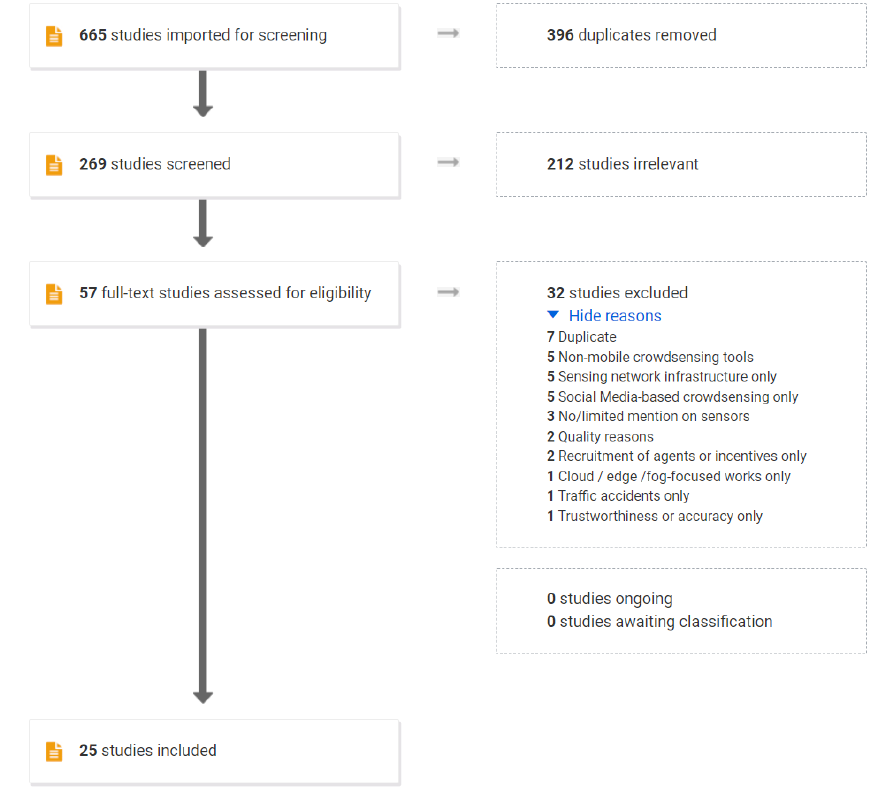
Figure 3. PRISMA diagram illustrating the paper selection